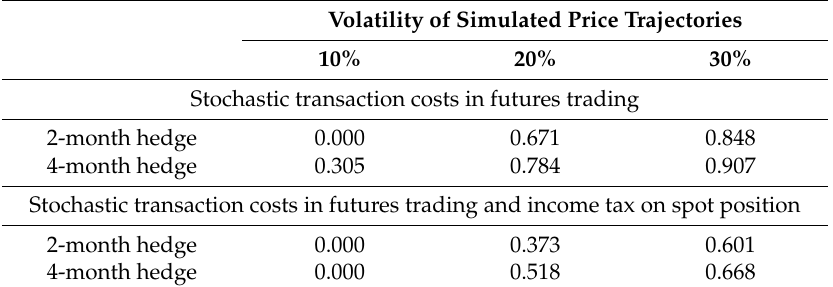
Table 6. Hedge ratios with stochastic transaction costs in futures